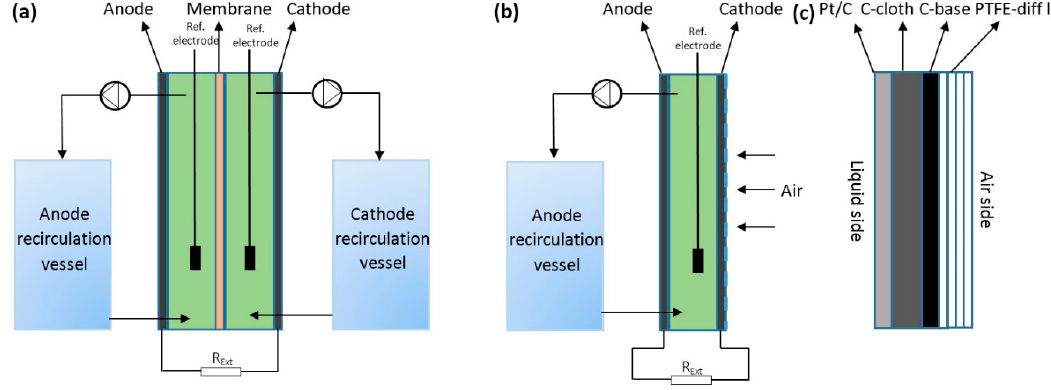
Figure 1. ( a ) Schematic diagram of the dual ‐ chamber microbial fuel cell (MFC) reactor used with the ferricyanide cathode (FeC) and dissolved oxygen cathode (DOC); ( b ) single ‐ chamber MFC reactor using an air cathode (AiC) electrode in a sandwich construction with the membrane; ( c ) composition of the AiC containing platinized carbon (Pt/C) coated carbon cloth (C ‐ cloth), one carbon base layer (C ‐ base) and four polytetrafluoroethylene diffusion layers (PTFE ‐ diff l) facing the air side. The circuit diagrams are indicated with external resistance ( R Ext ).